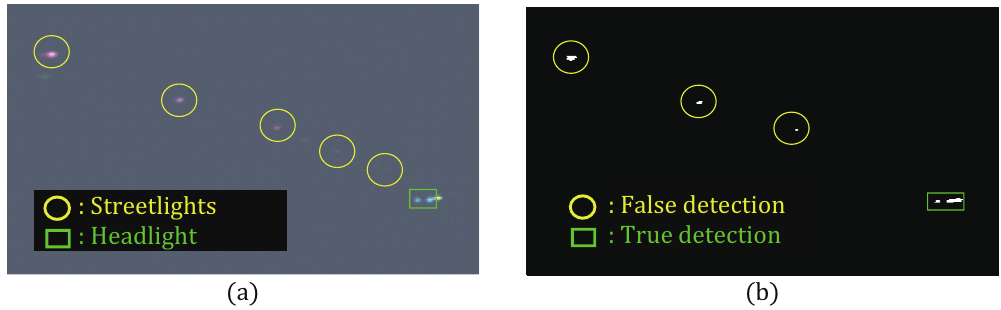
Figure 1. Previous headlight detection method: ( a ) composite image by extracting the RGB bands in the hyperspectral camera ( b ) binary image of headlight detection using the OTSU algorithm